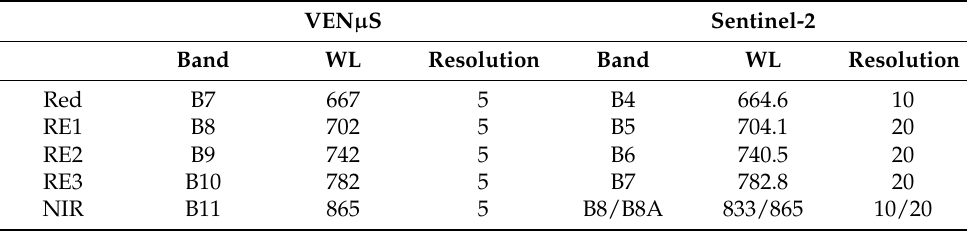
Table 2. VEN µ S and Sentinel-2 bands (used in the equations in Table 1): band number (Band), central wavelength (WL, nm), and spatial resolution (Resolution,